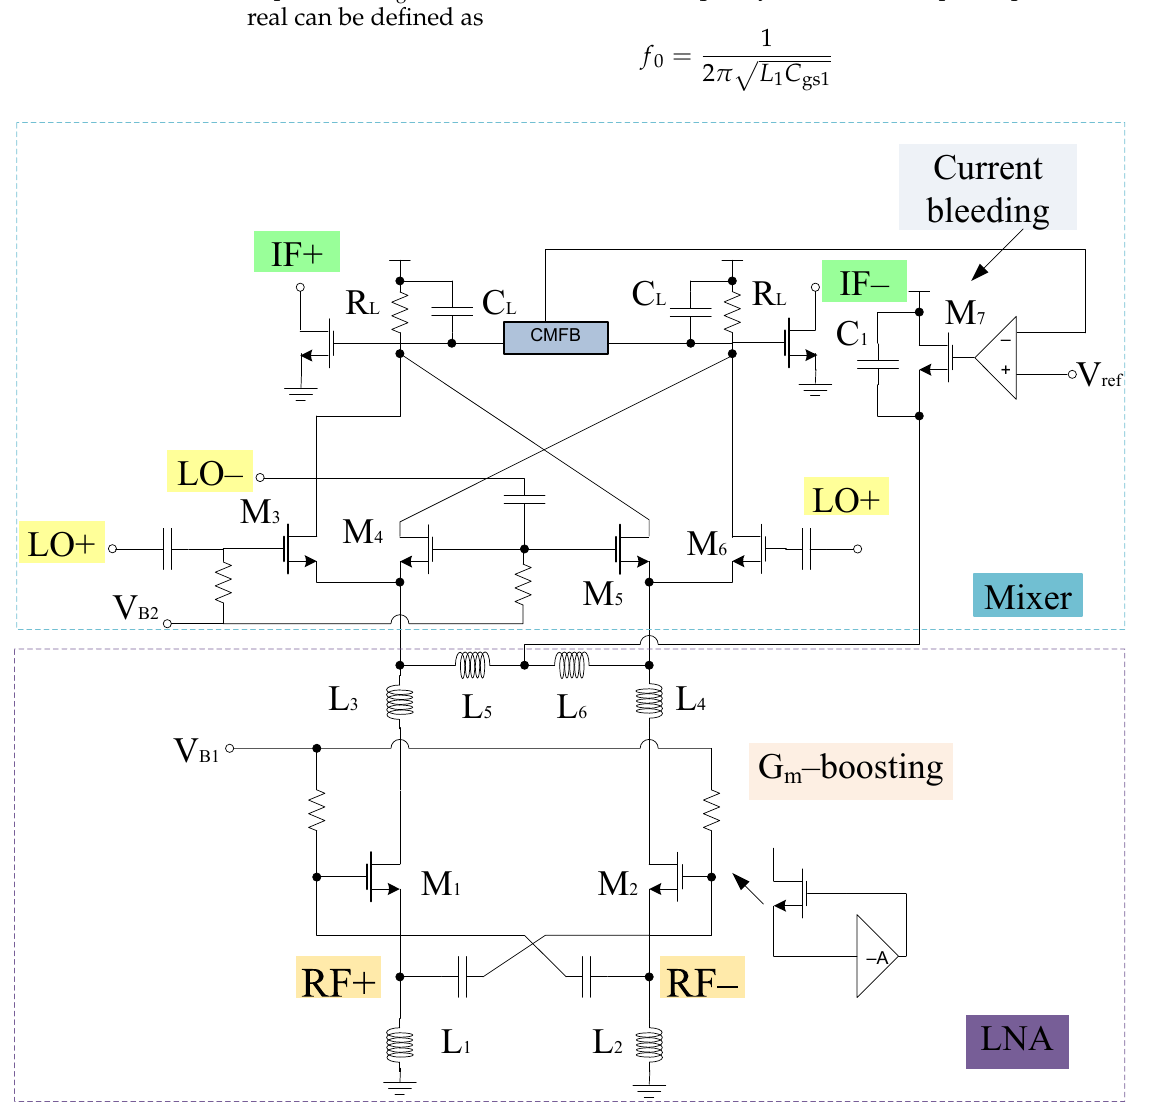
Figure 1. Merged LNA and